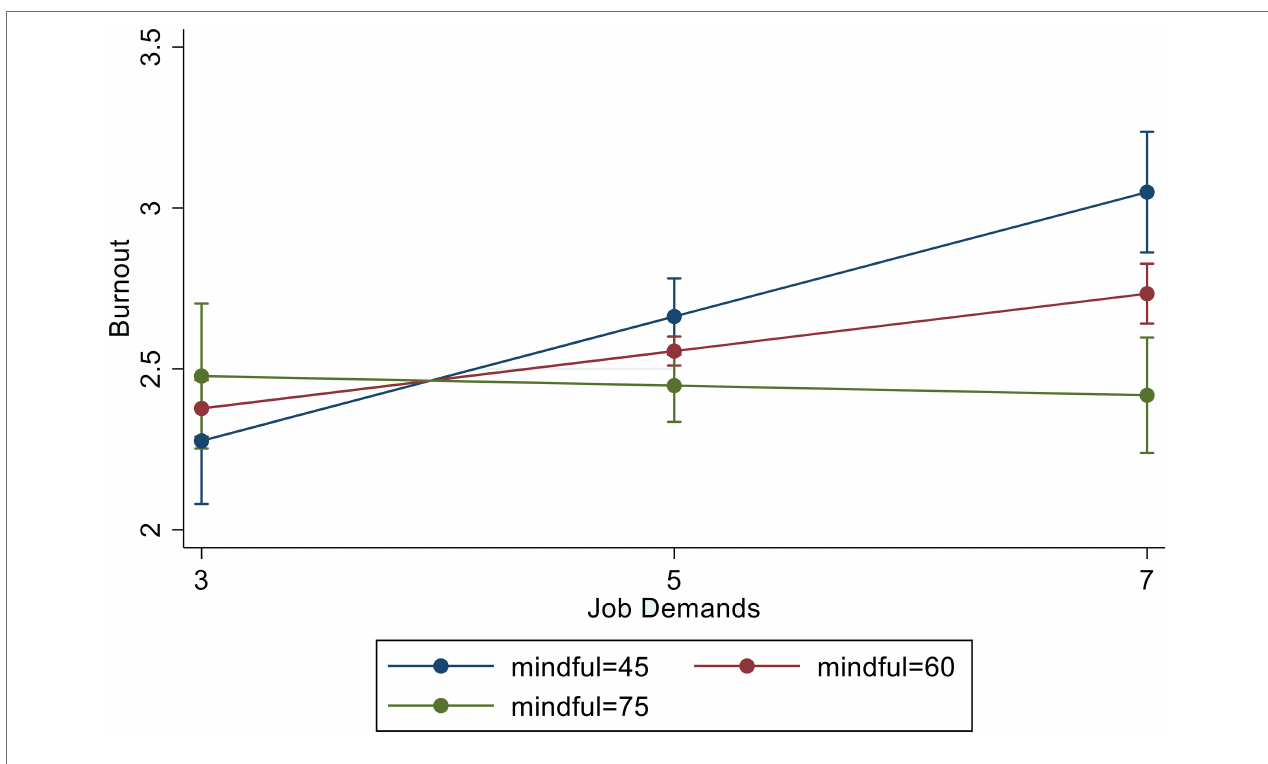
FIGURE 1 | Burnout by job demands and